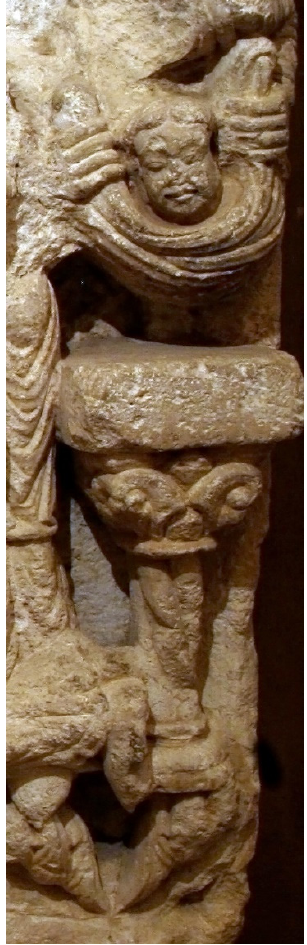
Figure 6. Almazán. Frontal (detail). Altar and elevation animae. Figure 6. Almaz á n. Frontal (detail). Altar and elevation